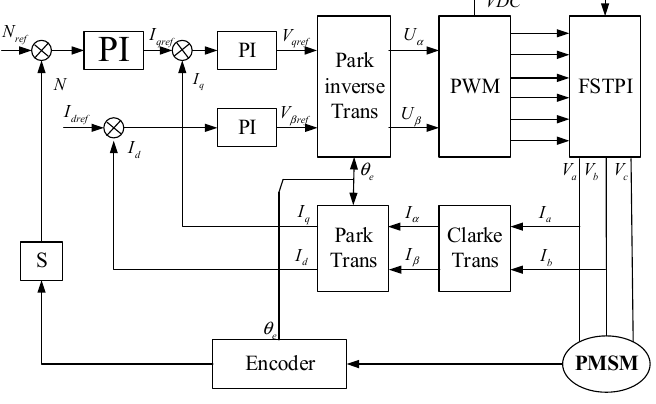
Figure 2. Structure diagram of PMSM.